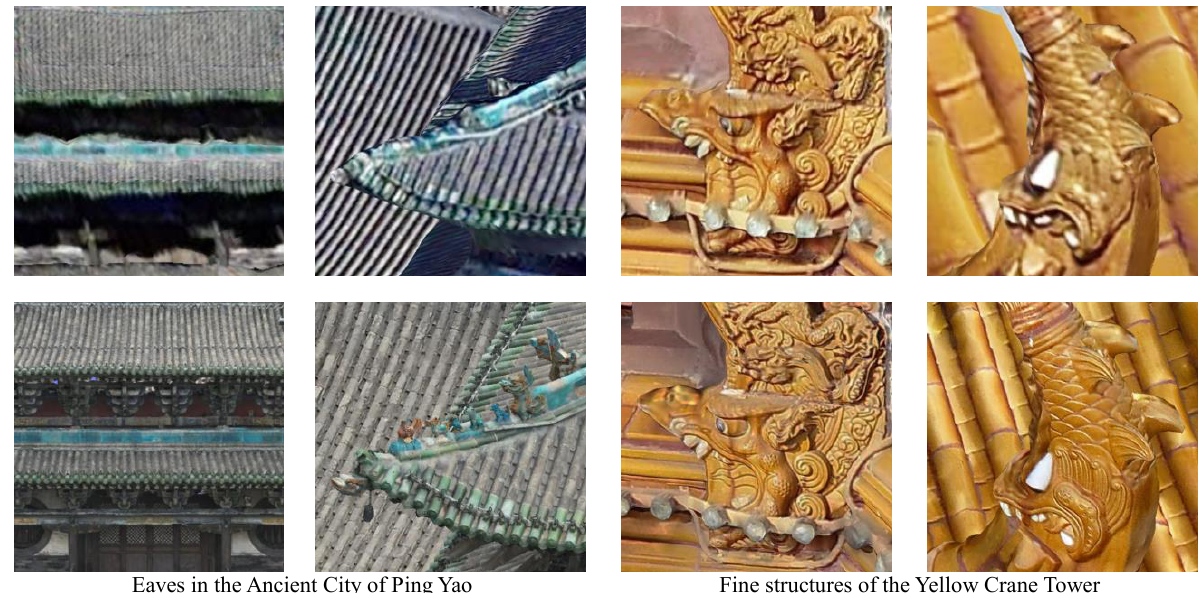
Figure 8 . Comparison of reconstruction results of different path planning methods. The first row shows the results of regular baselines whereas the second row shows the results of our path planning